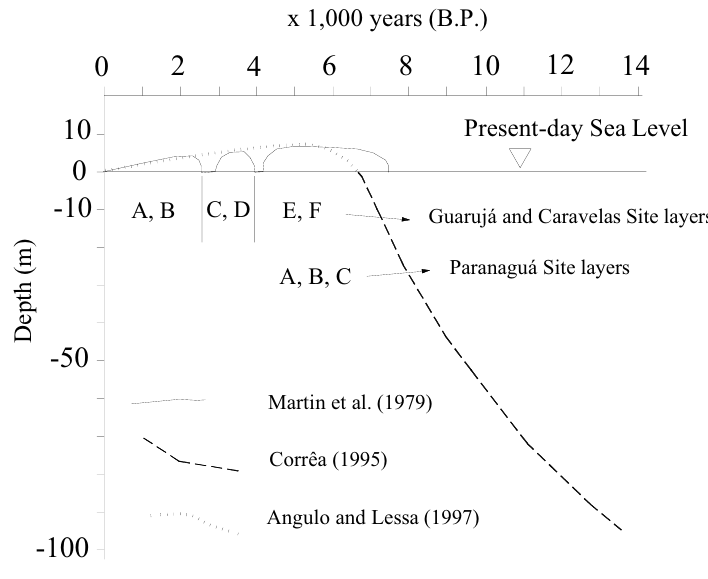
Fig. 13 – Sea levelfluctuations, indicated by several authors, and the indication of the main layers defined from piezocone test interpretation, for Caravelas, Guarujá and Paranaguá